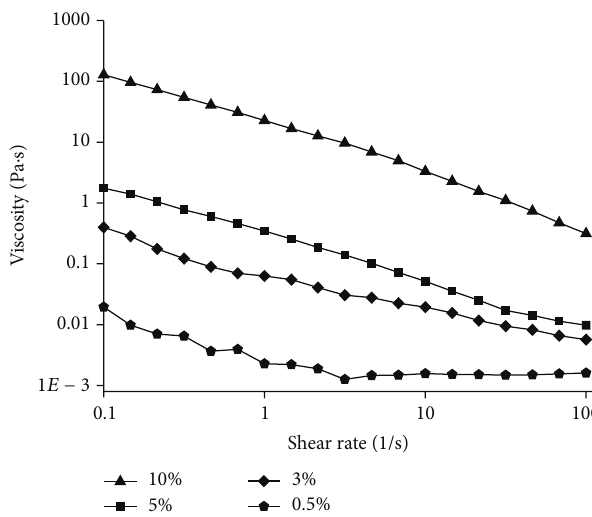
Figure 1: Steady shear flow curves of different concentration of